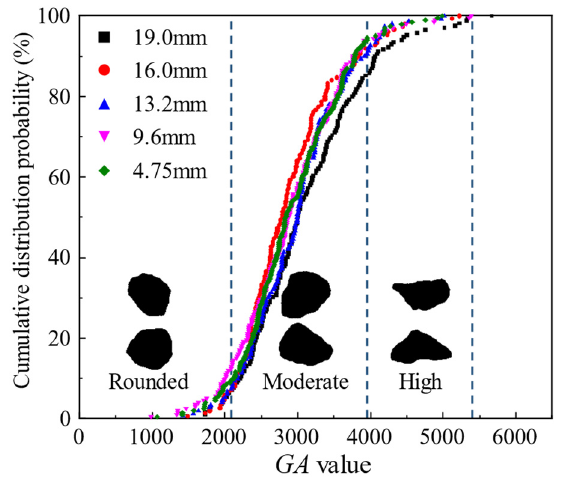
Figure 3. Distribution of GA values for aggregates.